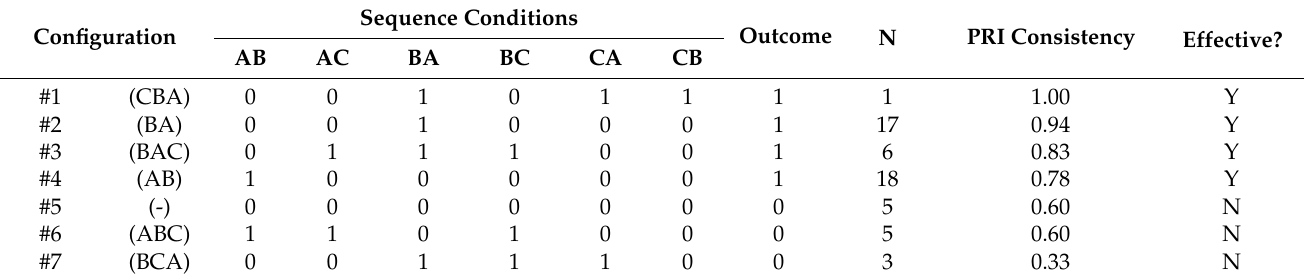
Table 3. The visual scan path configuration (Hazard #1).